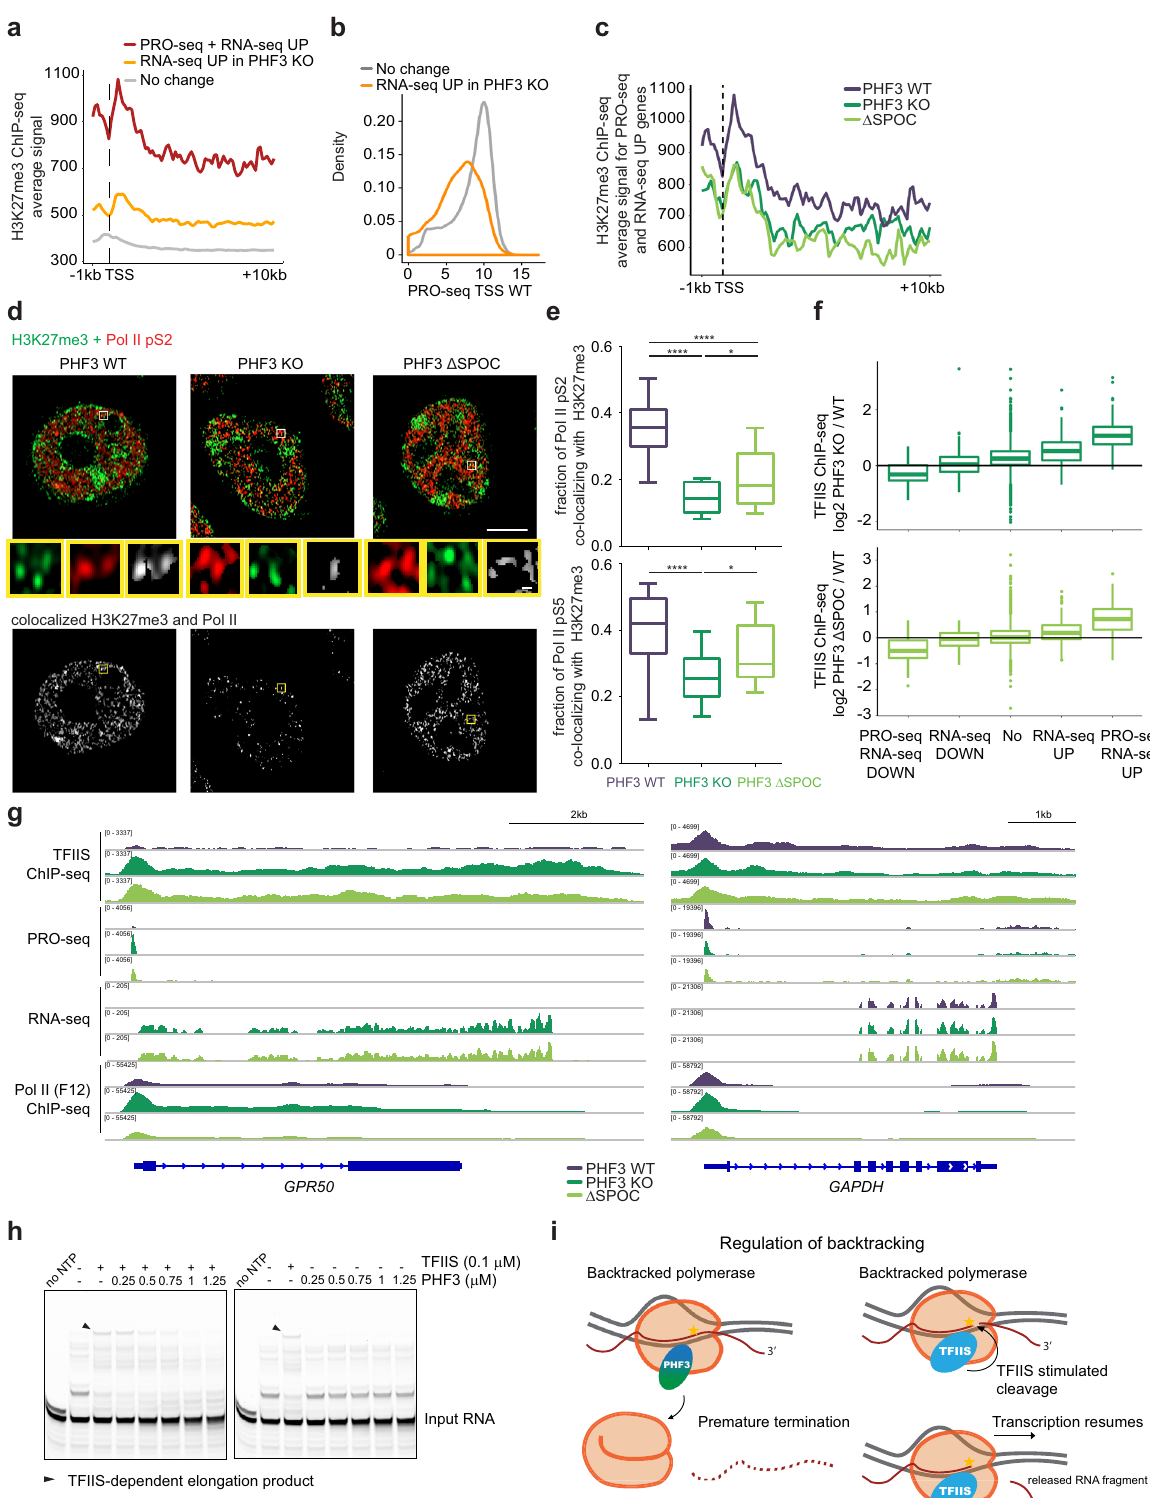
effects of PHF3 loss. Globally, PHF3 loss led to increased Pol II stalling and reduced elongation rate, with little effect on nascent transcript levels but with an increase in mRNA stability. A subset of ~600 genes was strongly derepressed (>2-fold increase in mature transcript levels), among which ~70 genes also showed a concomitant increase in nascent transcription. While globally